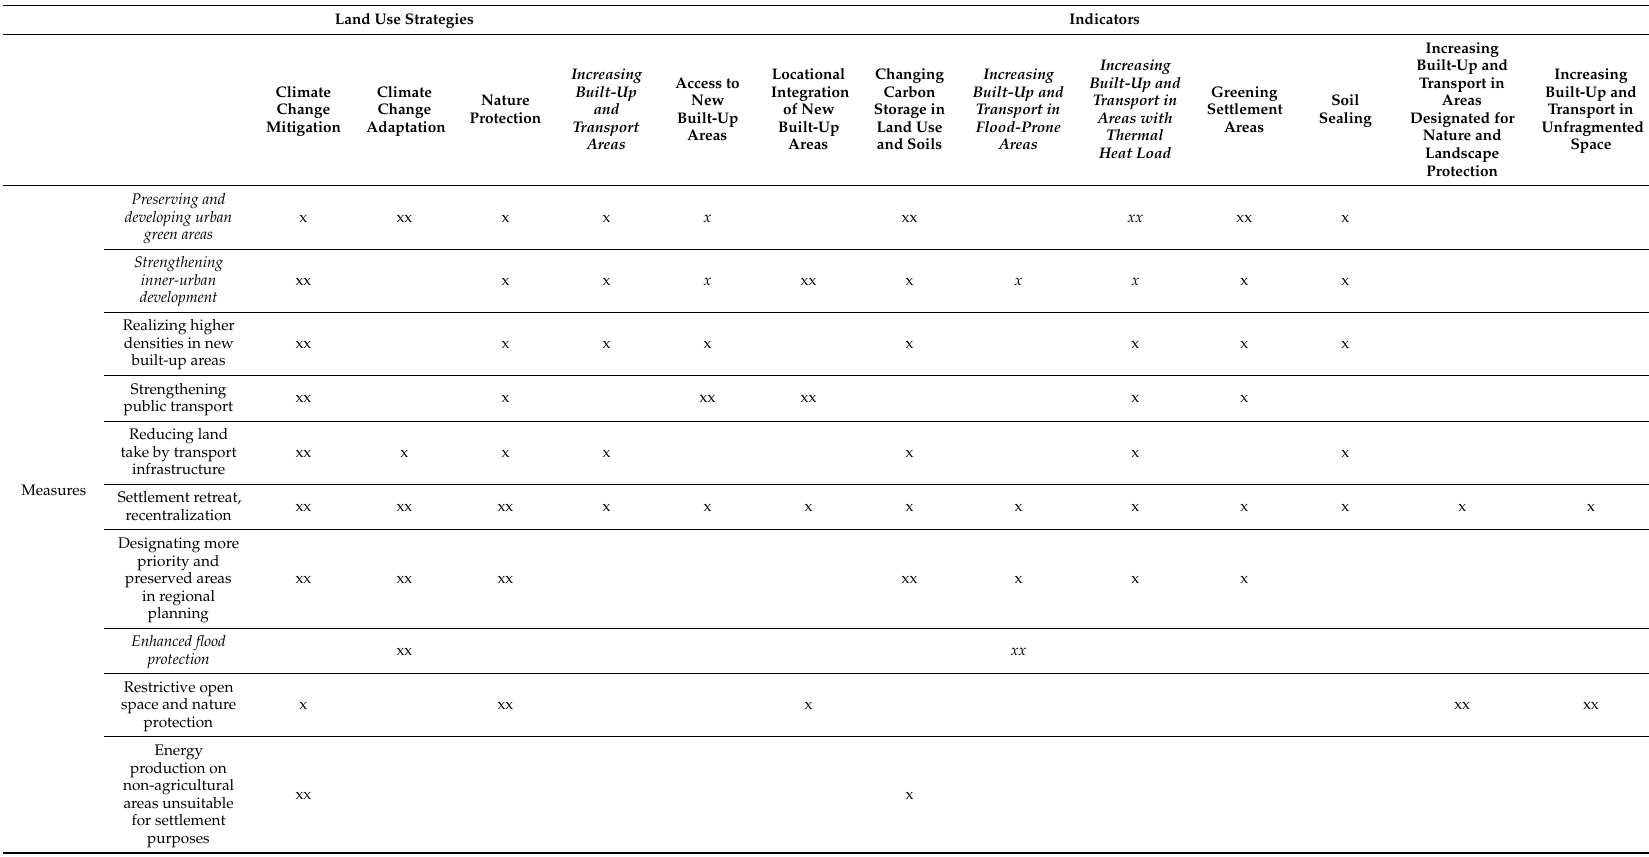
Table 1. Measures that control the settlement development, their assignments to a land use strategy, and to indicators that are used to measure their effect ( Measures and indicators presented in this publication are marked in italics